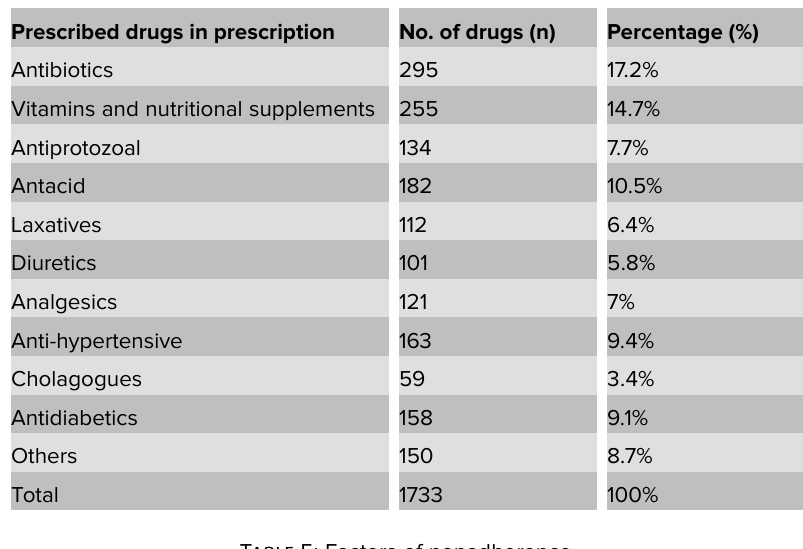
TABLE 5: Factors of